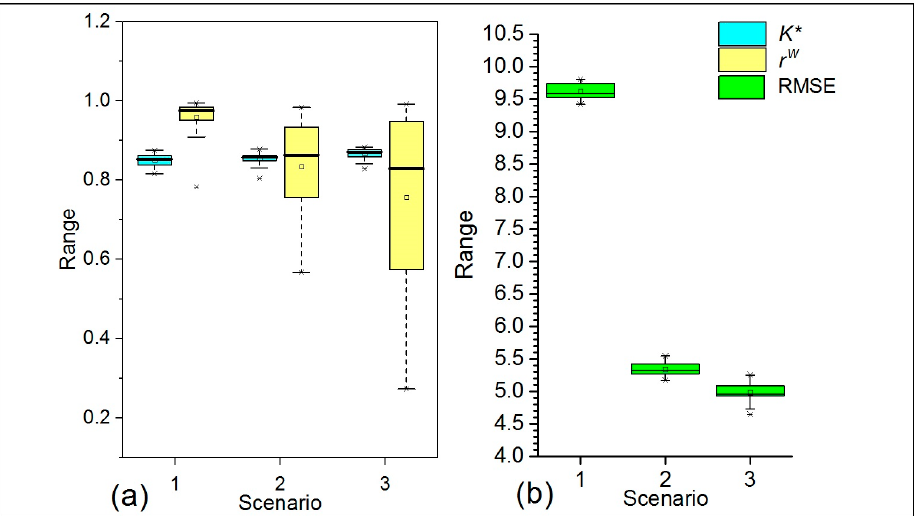
Figure 15. Comparison of both spatial and temporal measures of validity for all scenarios. ( a ) Spatial validity evaluation based on K* and r w ; and ( b ) temporal validity evaluation based on RMSE.